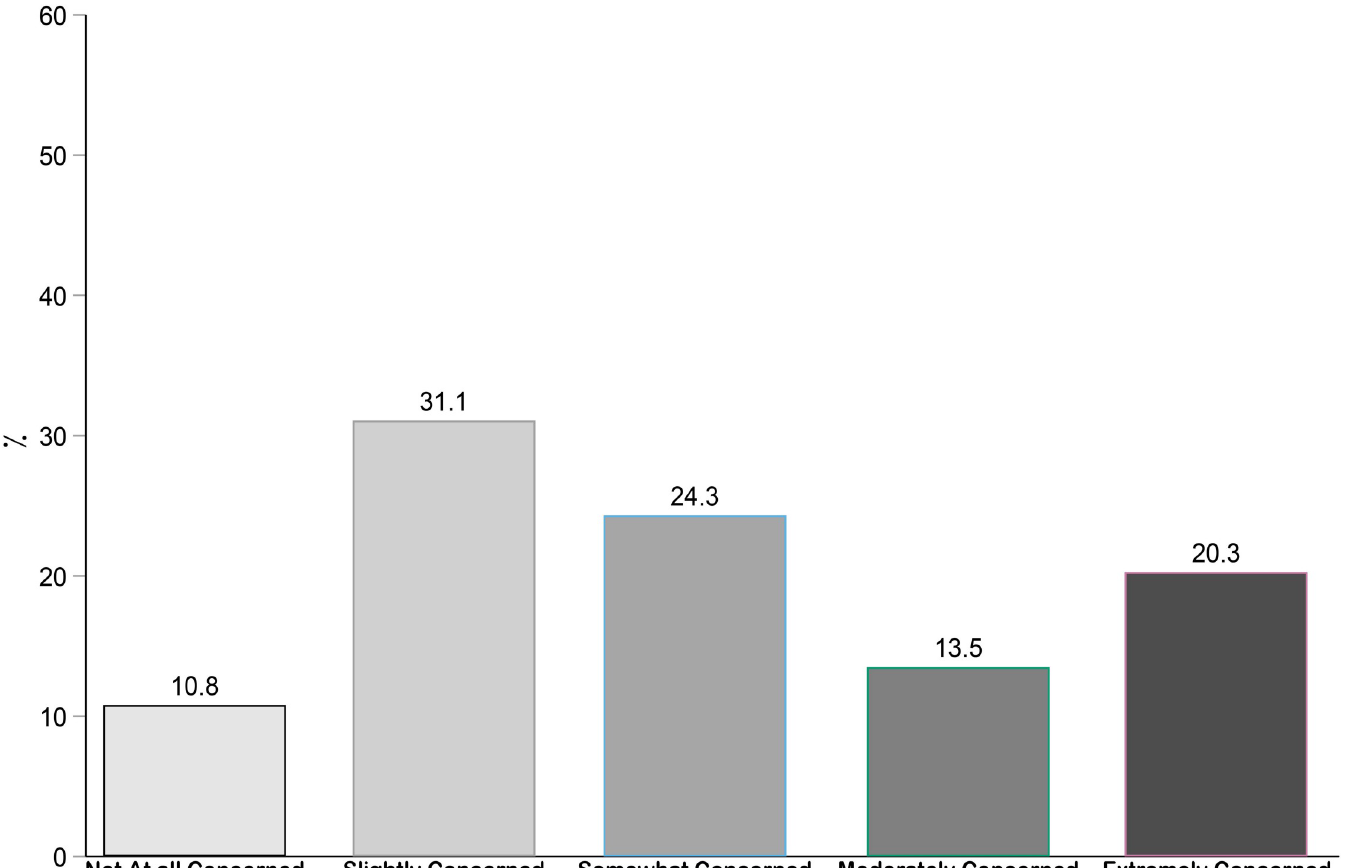
Fig 4. Concerns of pregnant women ( N = 74) about the risk for their children contracting COVID-19 during delivery in the